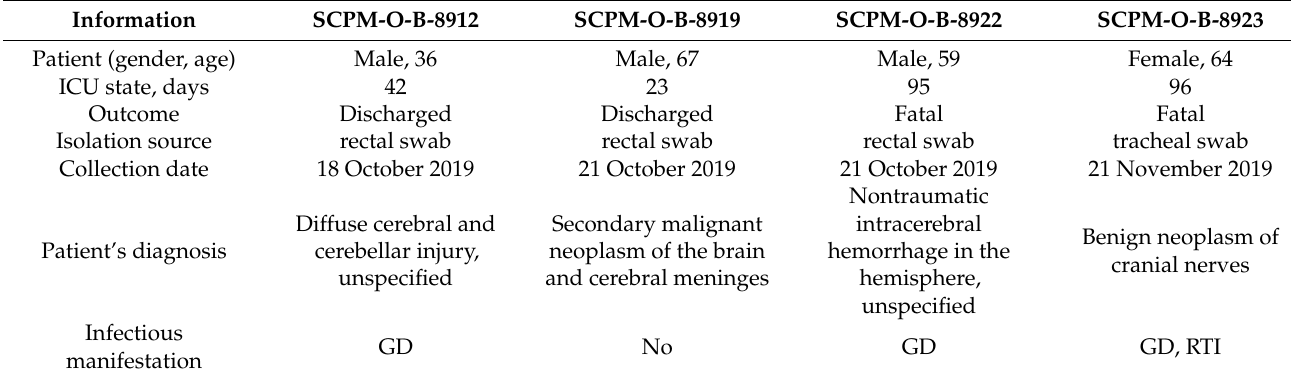
Table 1. Patient’s information.